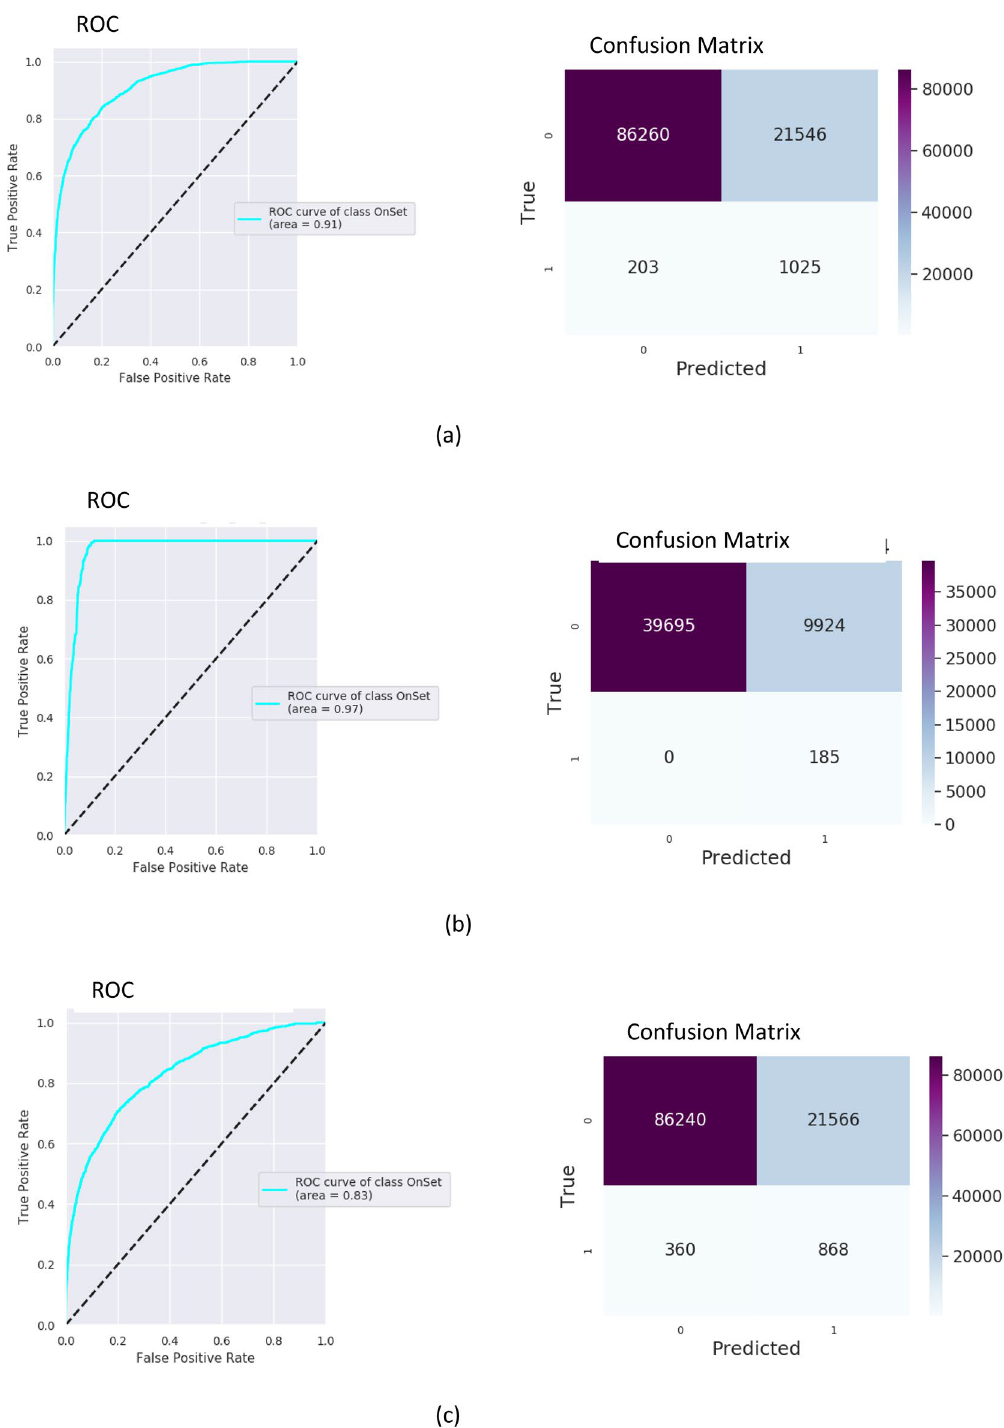
Figure 4. Testing receiver operator characteristic (ROC) curves and confusion matrices for MIMC III and the Rabin COVID-19 data using 6-h gaps for 1061 patients. An ROC curve is a graphical plot that illustrates the diagnostic ability of a binary classifier system as its discrimination threshold is varied. Confusion matrix summarizes the diagnostic ability of a binary classifier system when the threshold is chosen for the false positive rate of 0.2. Within the confusion matrix, cell (1,1) is the number of true positives, cell (0,0) is the number of true negatives, cell (0,1) is the number of false positives, cell (1,0) is the number of false negatives. Presented numbers are numbers of sliding window intervals used in testing procedure. ( a ) Training on MIMIC III with operational features. ( b ) Training on MIMIC-III with adaptation to Rabin COVID-19 and with operational features. ( c ) Training on MIMIC III without operational features. ( d ) Training on MIMIC-III with adaptation to Rabin COVID-19 and without operational features. ( e ) Training on Rabin COVID-19 with operational features. ( f ) Training on Rabin COVID-19 without operational